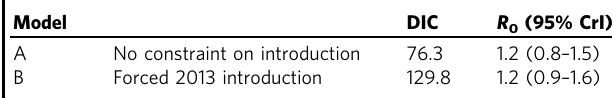
Table 1 Model performance and estimated R 0 when introduction date is unconstrained and constrained. The model with no constraint on introduction time estimated an early 2015 introduction, which meant there was no need for a DENV/ZIKV interaction to explain the observed data. In contrast, constraining the introduction time to 2013 resulted in an estimated interaction, but performed less well when compared to the observed serological and surveillance